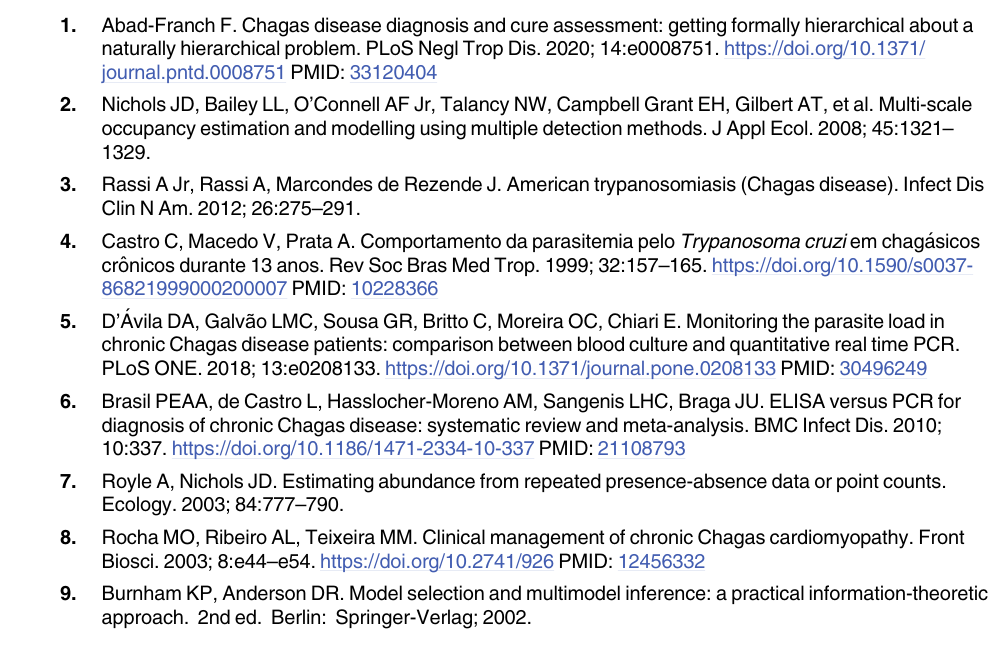
S1 Fig. Correlations between test sensitivity estimates and median parasite loads. Sensitiv- ity estimates are derived from 2 of the models fitted here (“M “M ”, lower half; see Table 1 of the main text), and parasite loads are as reported in [5]. Top S1 Table. Numerical values used to build Fig 1 of the main text. For Fig 1A, predicted values of sample-level target availability ( θ ) and 95% CIs across patient ages (from 25 to 81 y); for Fig 1B, predicted values of test-specific sensitivities ( p ) and 95% CIs across patient clinical condi-